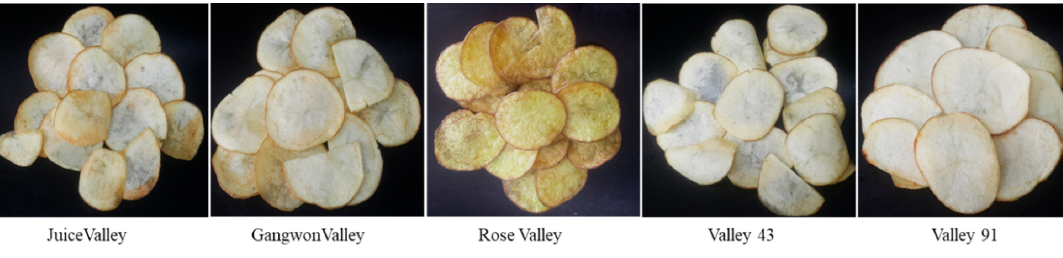
Figure 5. Fried chips of select potato lines.